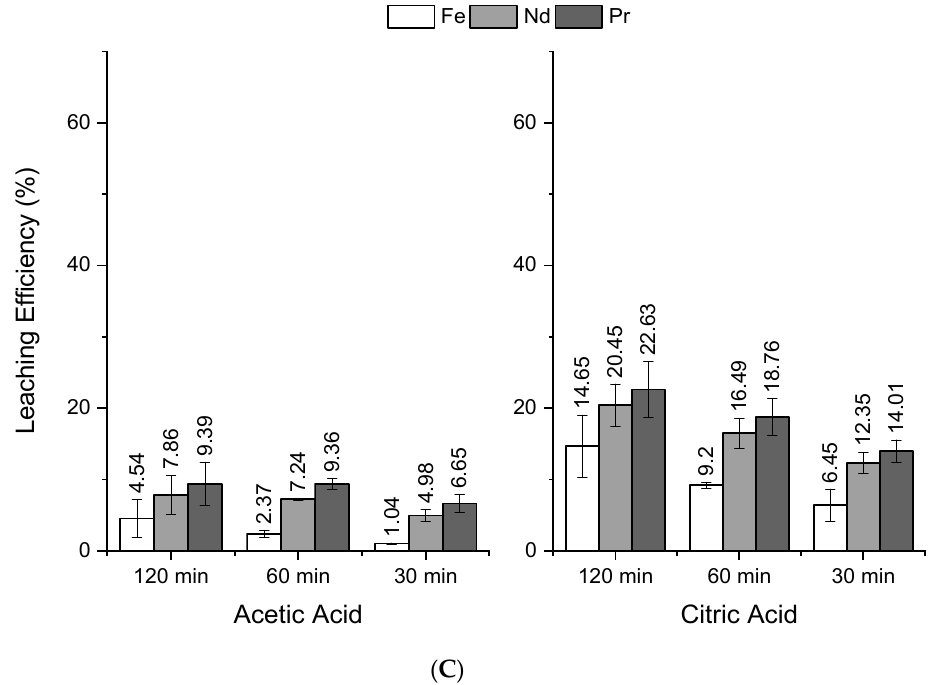
Figure 8. Comparison of the leaching efficiency of NdFeB magnets in acetic and citric acids, concen- tration 1 M, ratio s/l ( A ) 1/100; ( B ) 1/50 and ( C ) 1/10. The results obtained in the tests with acetic and citric acids at a concentration of 0.5